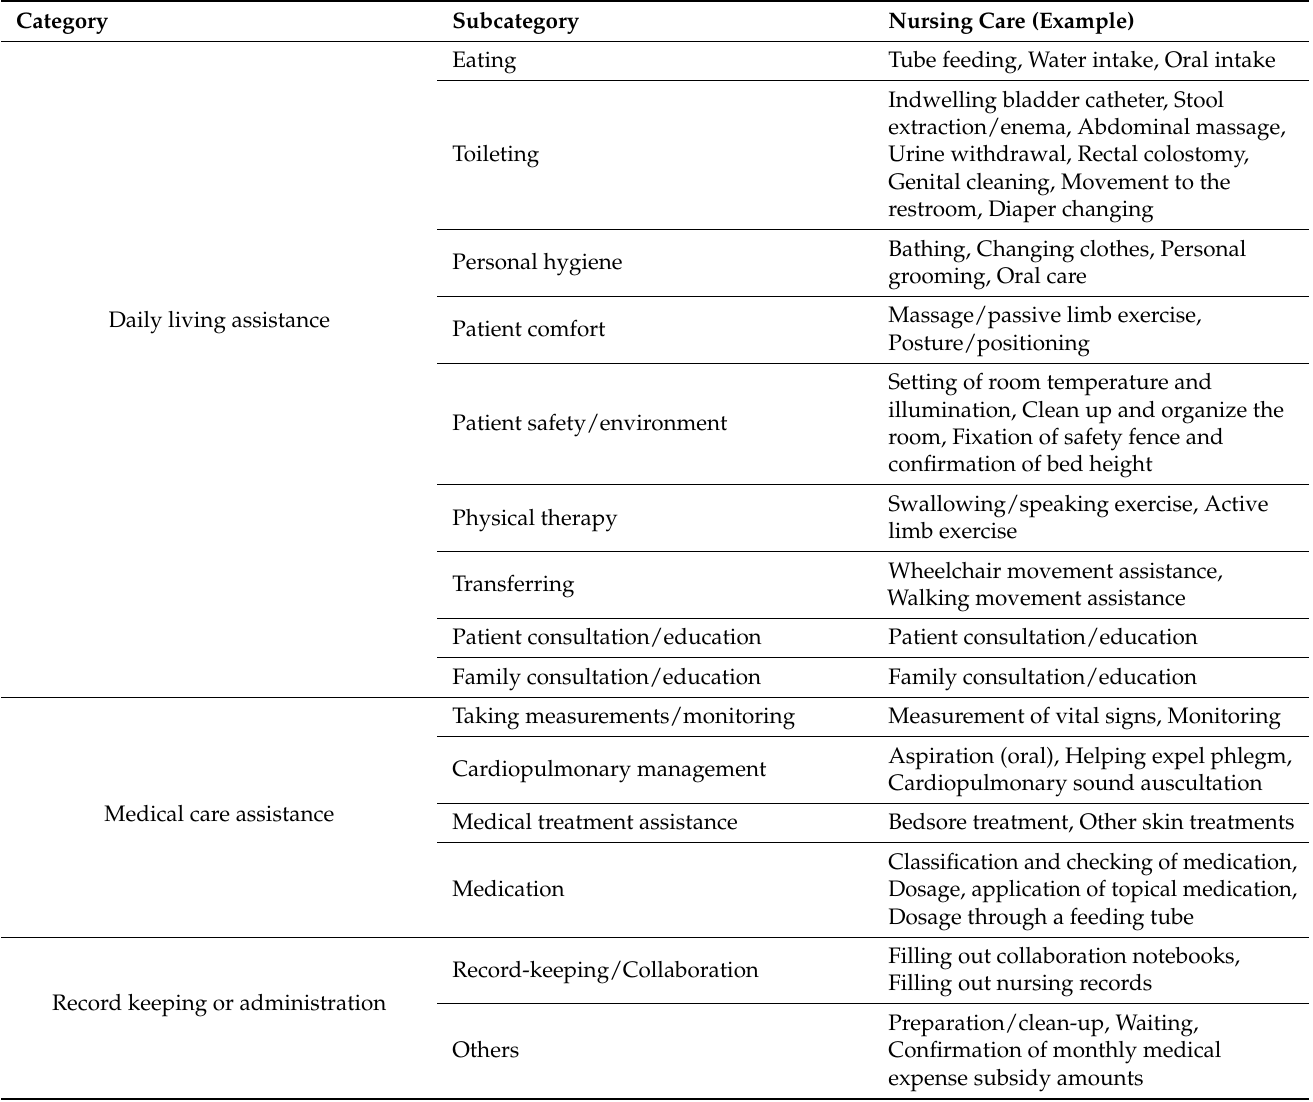
Table 4. Examples of divided nursing